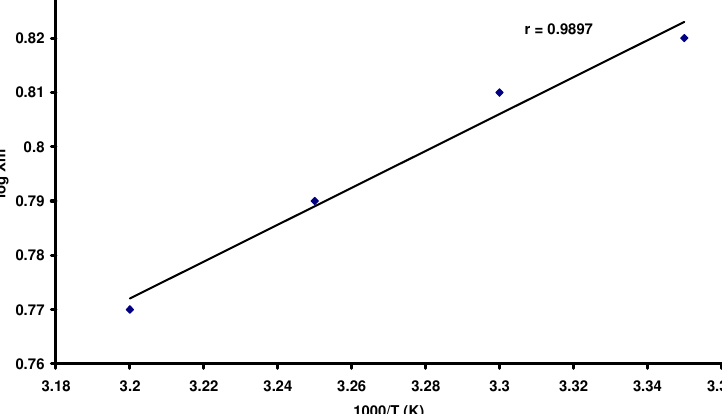
Figure 11. Relationship between the log Xm and 1/T of dye A with charcoal as an adsorbent